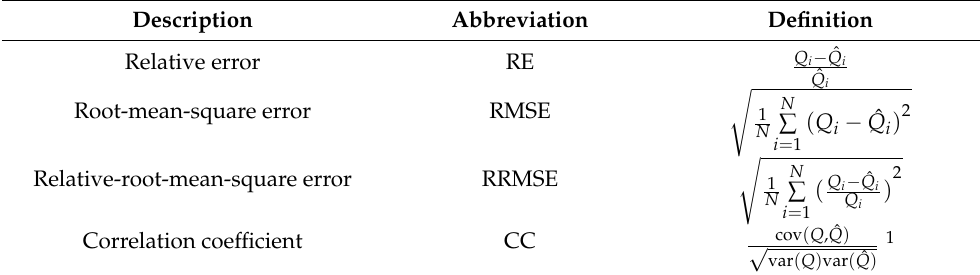
Table 3. Performance metrics used for the evaluation of AMHG discharge